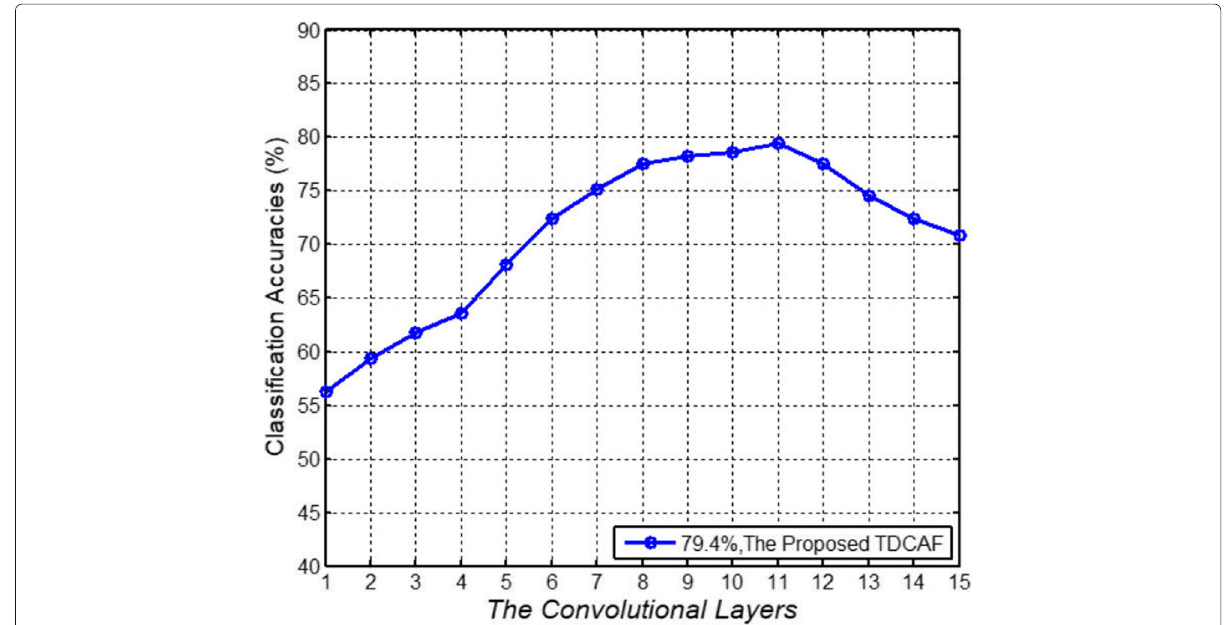
Fig. 5 Classification accuracies (%) of the proposed TDCAF in different convolutional layers on the CAMS_e to IAP_e